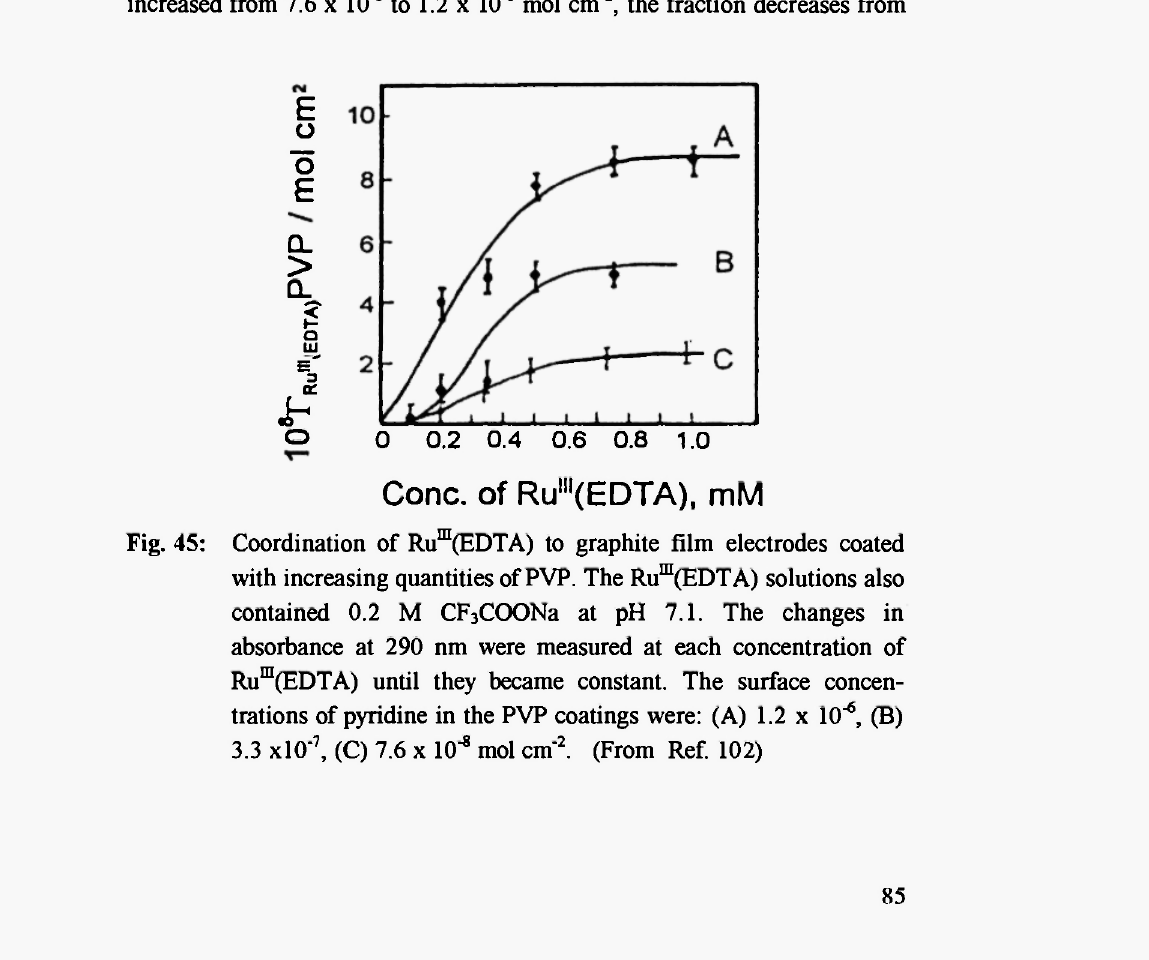
Fig. 45: Coordination of Ru m (EDTA) to graphite film electrodes coated with increasing quantities of PVP. The Ru m (EDTA) solutions also contained 0.2 Μ CF COONa at pH 7.1. The changes in 3 absorbance at 290 nm were measured at each concentration of Ru m (EDTA) until they became constant. The surface concen- trations of pyridine in the PVP coatings were: (A) 1.2 χ 10" 6 , (B) 3.3 xlO" 7 , (C) 7.6 χ 10" 8 mol cm" 2 . (From Ref.